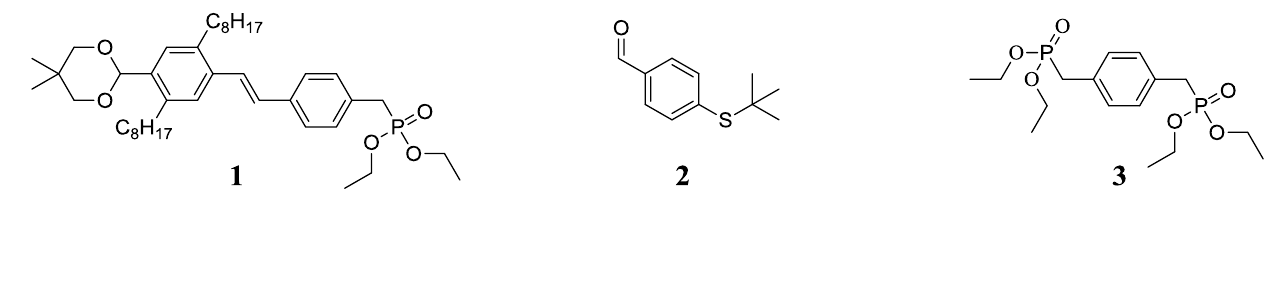
Figure 2. Chemical structure of the three building blocks used for in the preparation of the